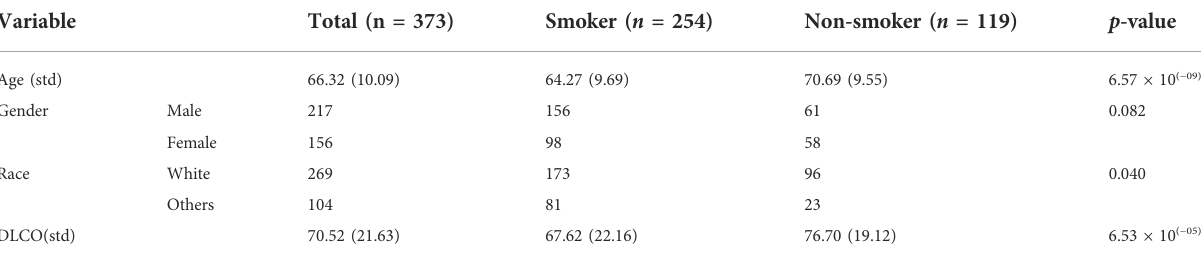
TABLE 4 Clinical characteristics of the patients in the smoker (S) and non-smoker (NS) groups.